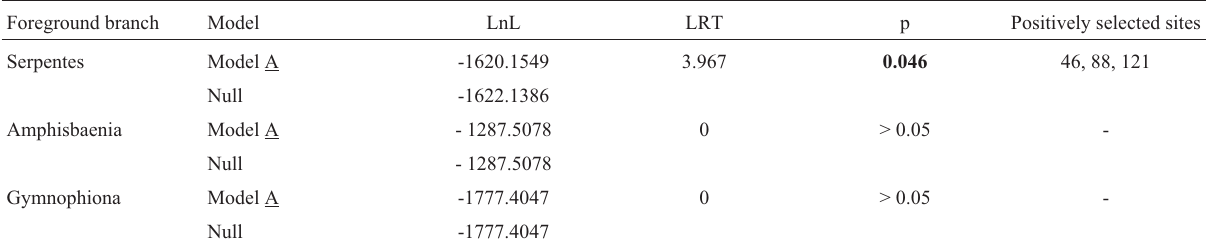
Table1 -Summaryoflikelihood-ratiotestsperformedusingbranch-sitemodelsimplementedinPALM.Log-likelihoodvaluesofdifferentmodelstested using Amphisbaena, Serpentes or Gymnophiona labeled as foreground branches. LnL corresponds to the likelihood value. Sites inferred under positive selection in Serpentes had posterior probabilities values of 0.64, 0.76 and 0.51,